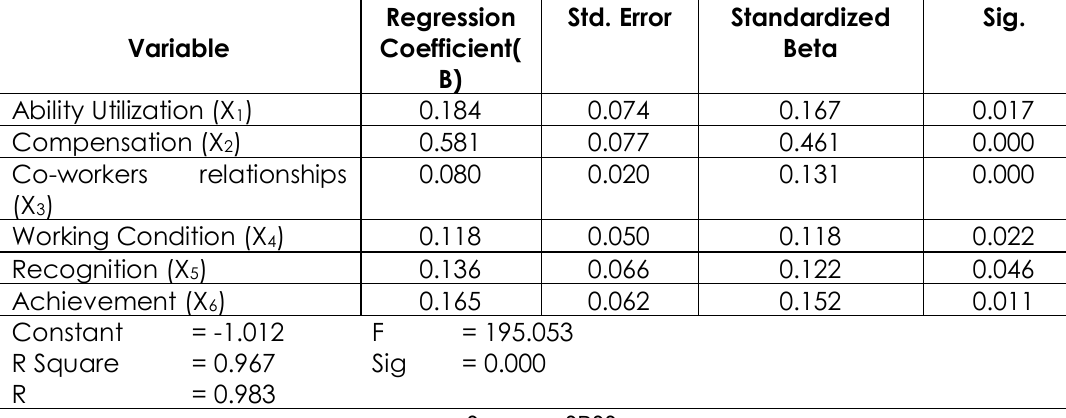
Table 2. Results of the regression